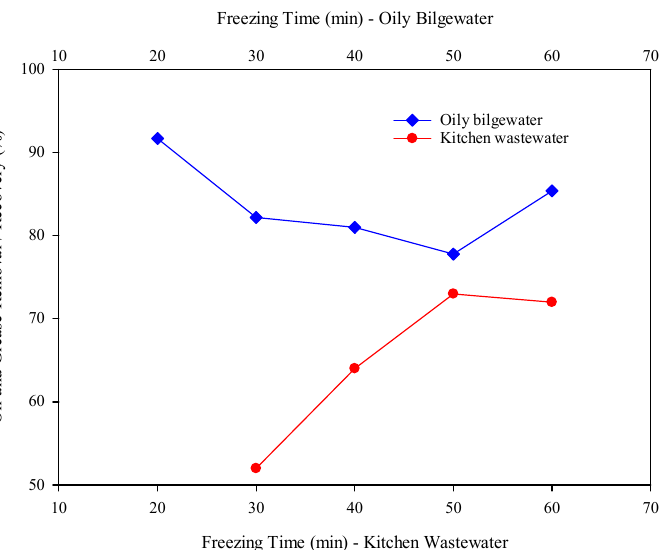
Figure 4. Changes of oil and grease removal/recovery for oily bilgewater and kitchen wastewater samples at a different freezing time (min).